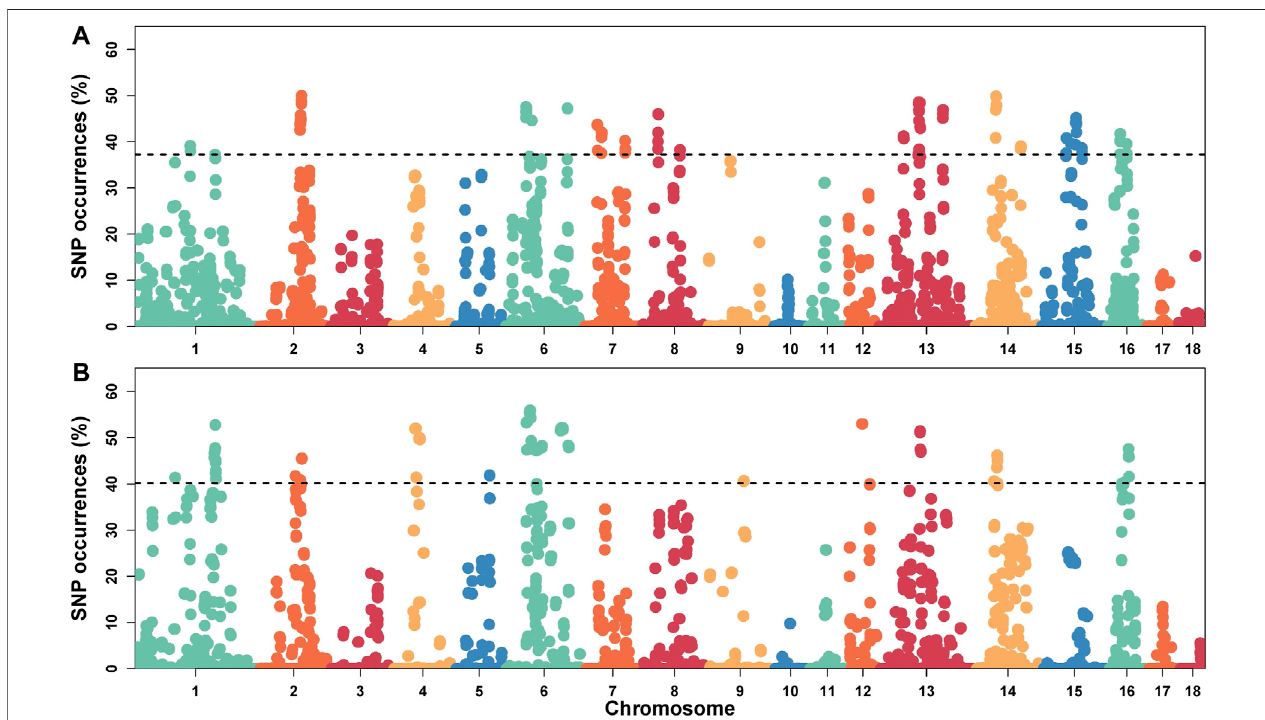
FIGURE 2 | Manhattan plot of the incidence of heterozygotes within ROHets in two Duroc populations. (A) The S21 population. (B) The S22 population. The dashed lines denote the top 1% threshold.